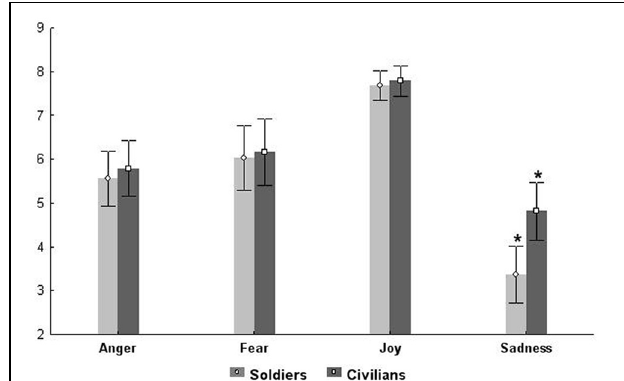
FIGURE 7 | Movies. Plots show the results of the ANOVA performed on the correct answers given by both groups of participants. The correct